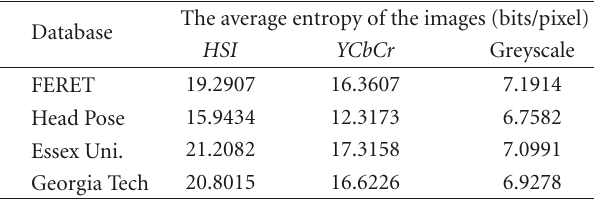
Table 1: The entropy of colour images in di ff erent colour channels compared with the greyscale